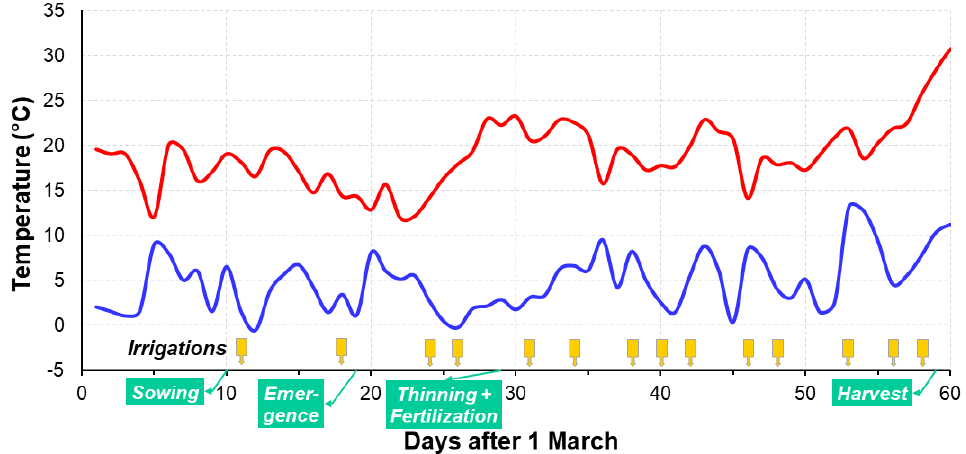
Figure 1. Daily minimum (blue line) and maximum (red line) temperatures during the trial period. The arrows indicate the dates of irrigation. Dates of sowing, emergence, thinning and N fertilization, and harvest are also indicated.